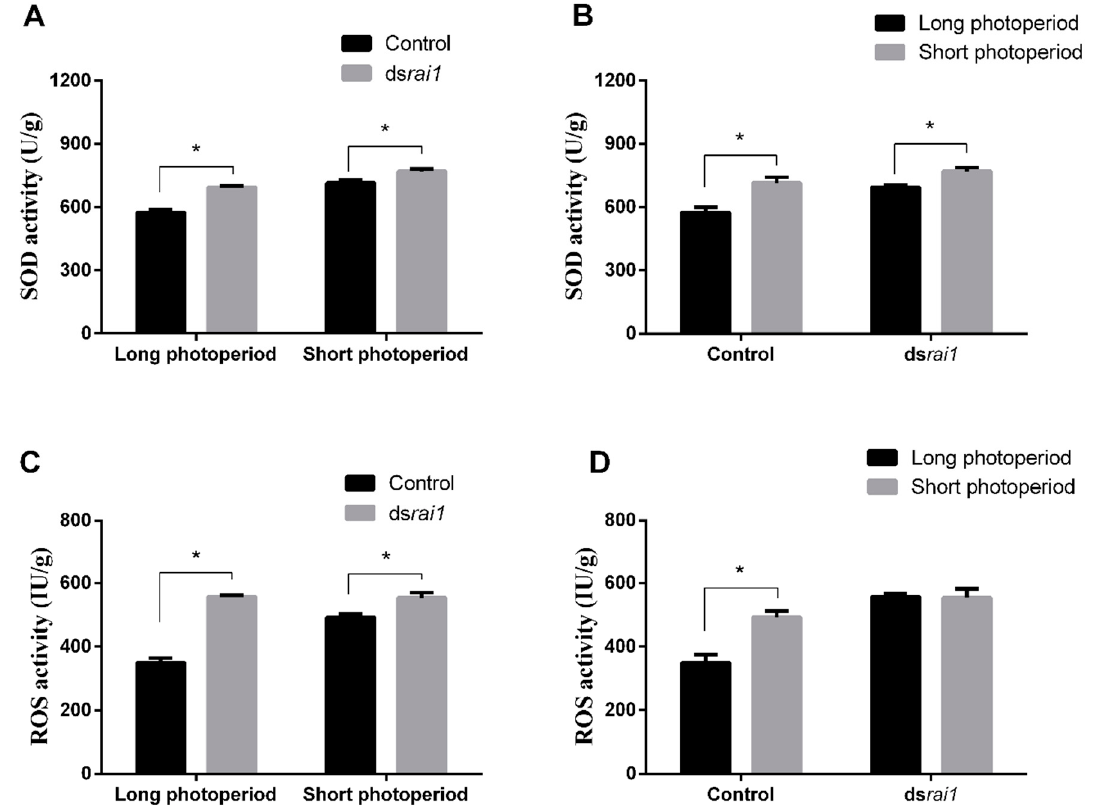
Figure 5. ( A , B ) SOD activity detected after injecting dsRNA of rai1 to locusts under both long and short photoperiods. ( C , D ) ROS activity detected after injecting dsRNA of rai1 to locusts under both long and short photoperiods. For each treatment, three replications were performed. Values were reported as mean ± SE. * Indicates an error probability of p < 0.05 using Student’s t -test.